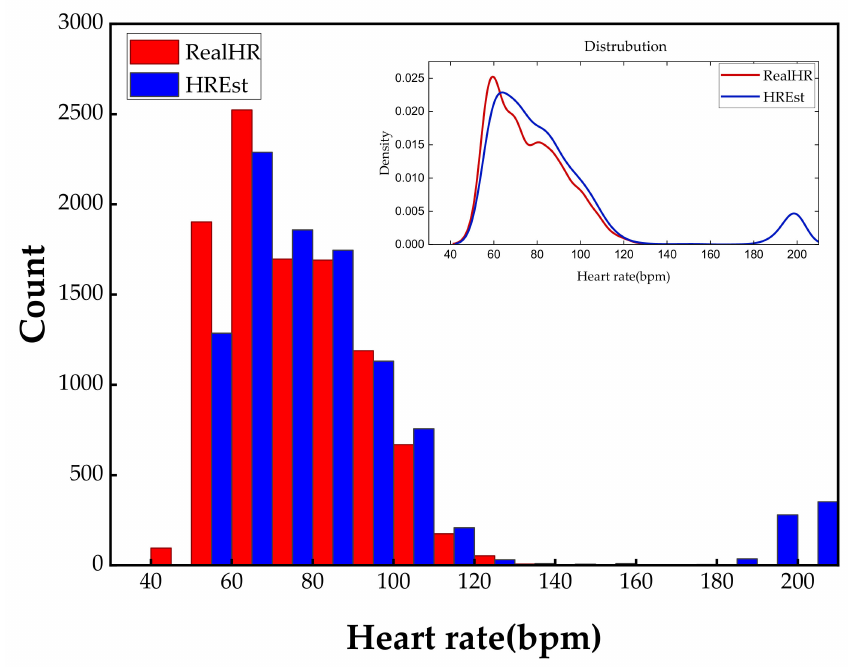
Figure 7. The statistical histograms of real HR and estimated HR in the test set. The red bar represents the ground truth HR, and the blue bar represents the predicted values by TCN. We also plot the kernel density curves of real HR and estimated HR with the red line and blue line, respectively, in the upper right